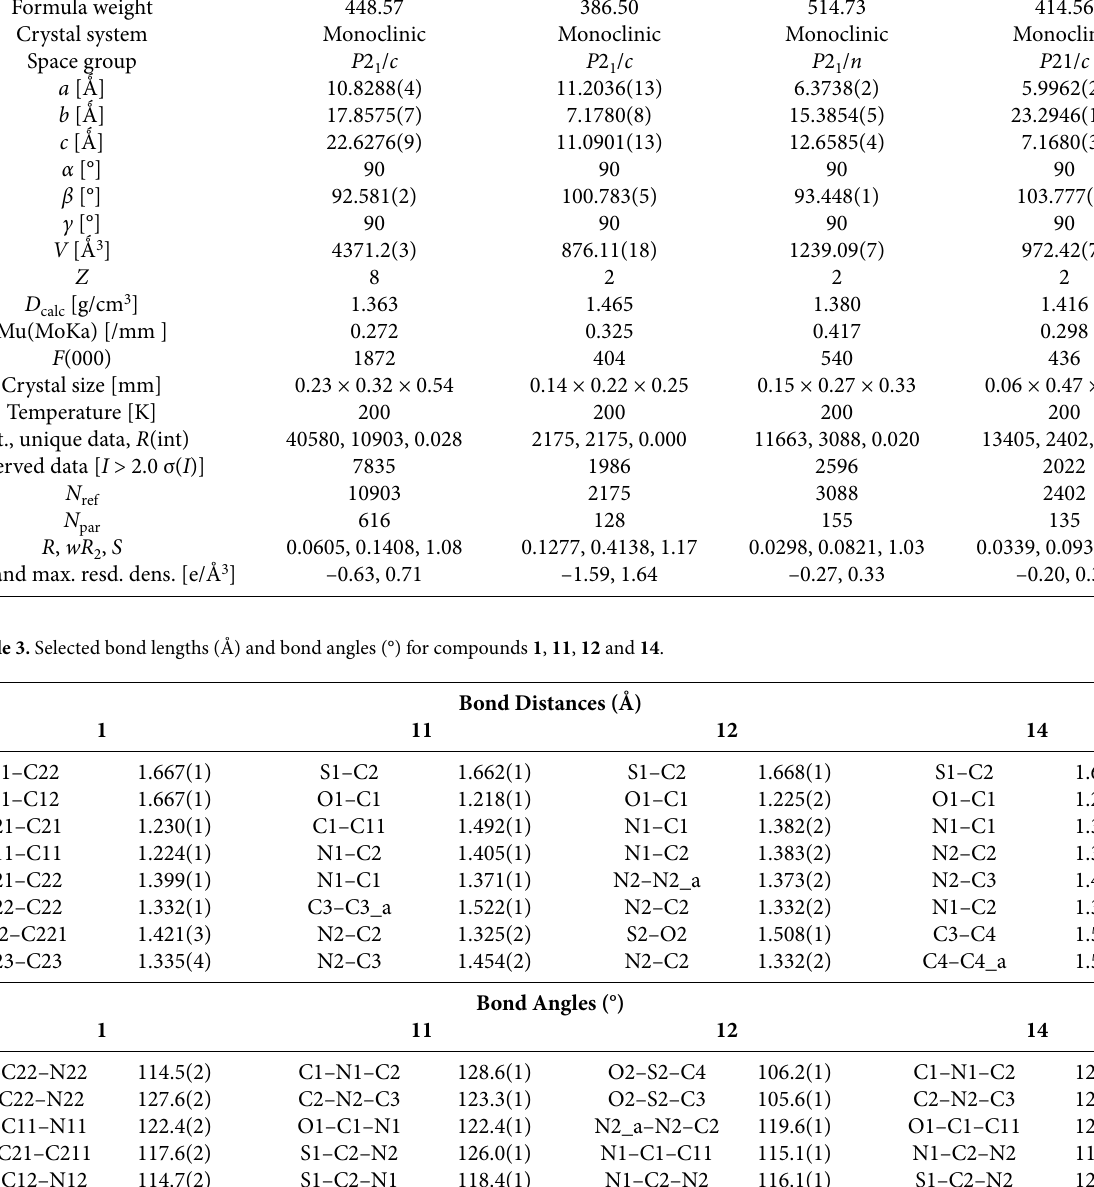
Table 2. Crystallographic data and structure refinement summary for compounds 1 , 11 , 12 and 14 . Property